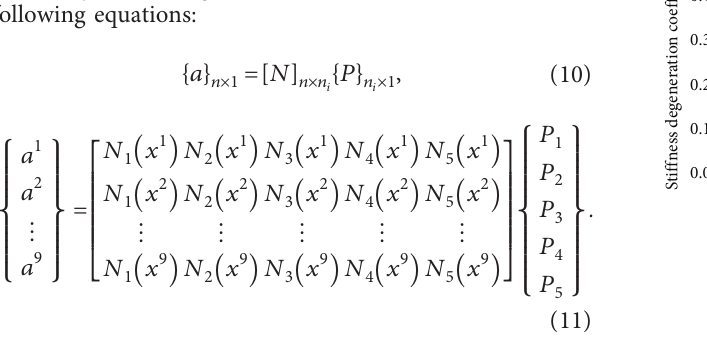
Figure 24: Stiffness degradation curve of the steel-concrete composite